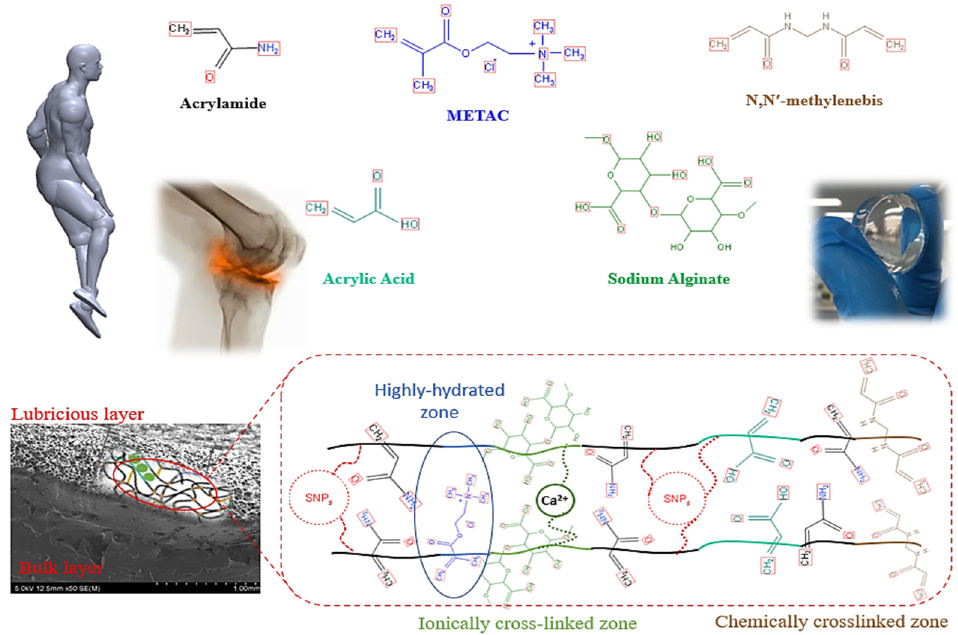
Figure 1. Utilized materials and IPNs structure of the NRH and NCHs.